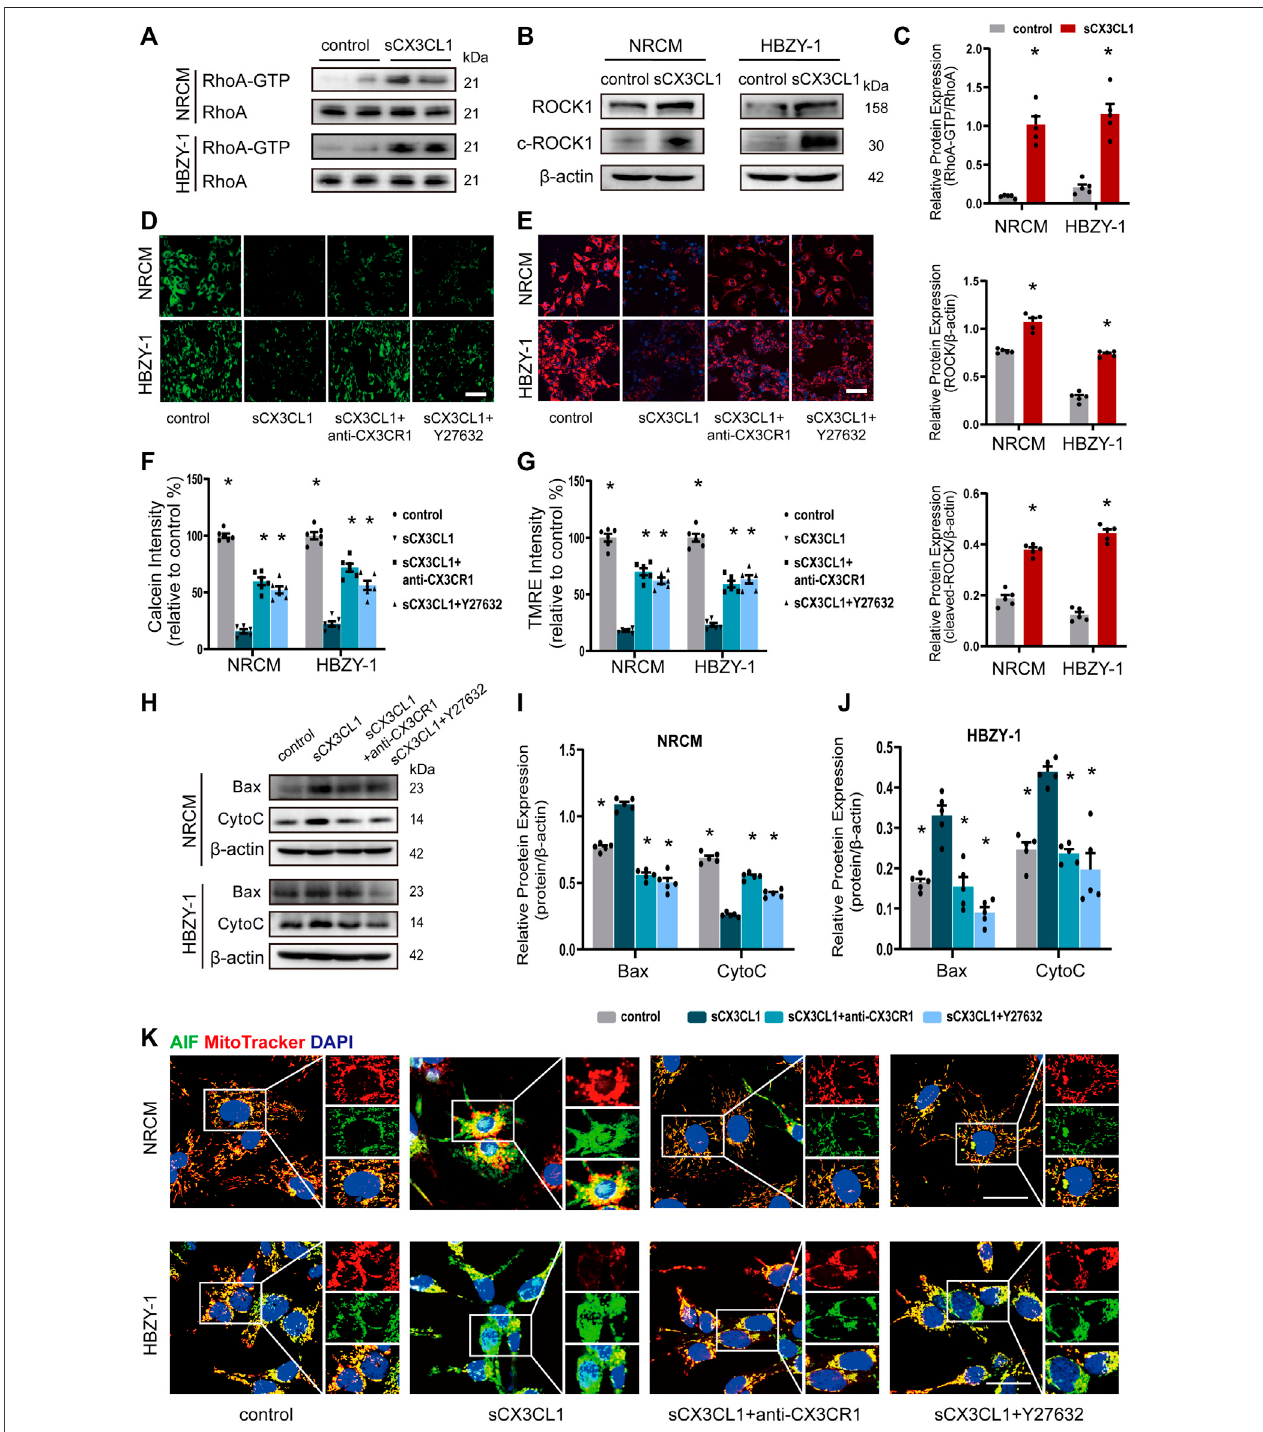
FIGURE 2 | sCX3CL1 promotes mitochondrial-dependent apoptosis in cardiomyocytes and renal cells. (A) Western blotting to detect RhoA and GTP-bound RhoA protein in neonatal rat cardiomyocytes (NRCM) and HBZY-1 cells after 60 min of stimulation with 200 ng/ml of sCX3CL1 (soluble CX3CL1). (B) Western blotting to detect upregulation of ROCK1 and cleaved ROCK1 (c-ROCK) expression in response to stimulation of NRCM and HBZY-1 cells with sCX3CL1 (200 ng/ml) for 24 h. (C) Semi- quantitationofRhoA-GTP, ROCK and cleaved-ROCKexpression. * p < 0.05 vs . control, n = 5 ineach group.Representative imagesof (D) calcein fl uorescence or (E) TMRE fl uorescence (Mitochondrial membrane potential) in cells cultured with sCX3CL1 alone or co-treated with either a CX3CR1 neutralizing antibody or a Rho kinase inhibitor(Y-27632).Scalebar=100 μ m.Semi-quantitativeanalysisofcalcein (F) orTMRE (G) fl uorescenceintensity(* p < 0.05 vs .sCX3CL1), n =5ineachgroup. (H) Western